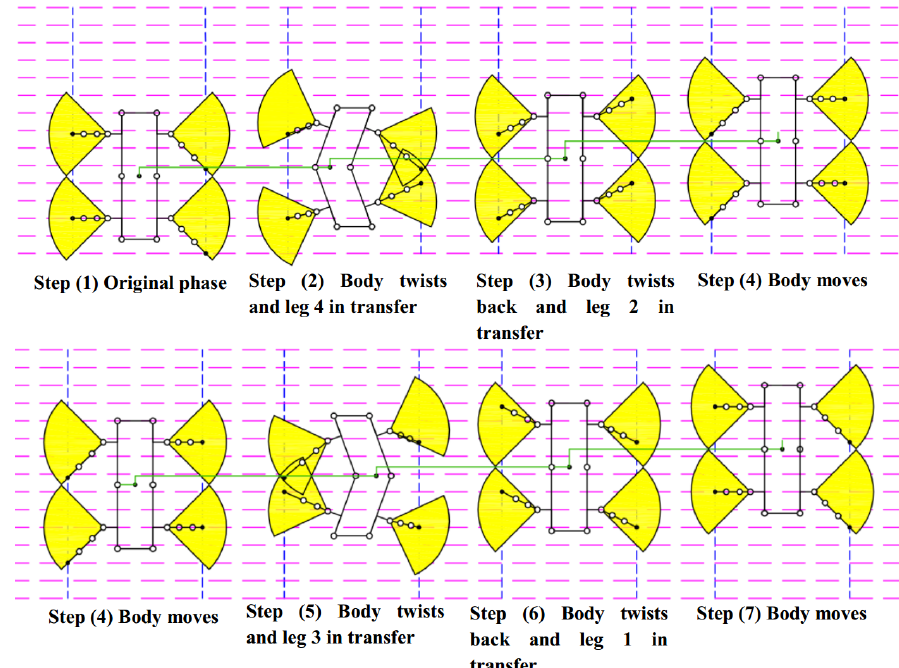
Figure 4. The motion sequence of the MetaRobot I executing the continuous periodic gait in one period. The black point in center of the trunk represents the COG of the robot. The green lines are used to describe the displacement of the robot after each step. The quadrant in yellow indicates reachable areas of footholds of